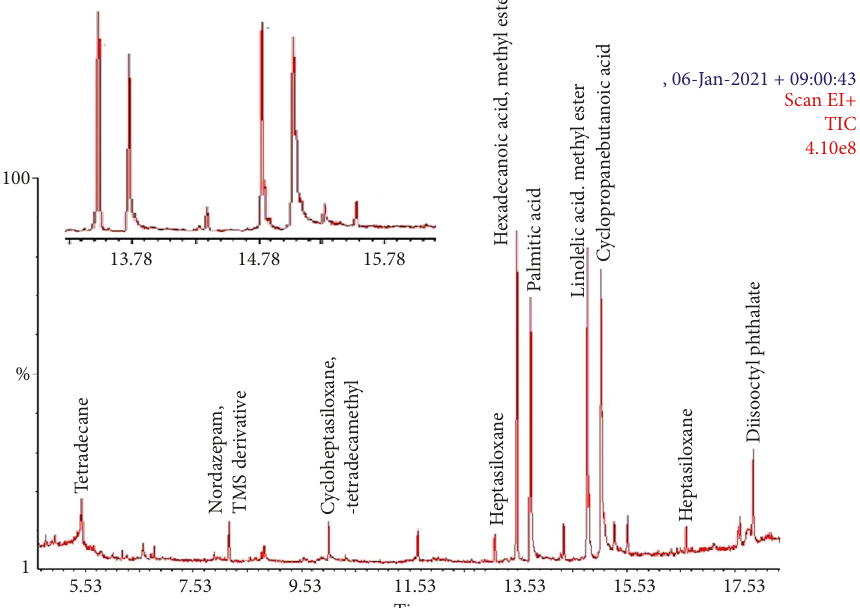
Figure 3: GC-FID chromatogram of aerial parts of essential oil of CSC � C. scolymus L. choke on HP-5MS column. The numbering of the identified peaks is given according to the serial number of compounds in Table 1.